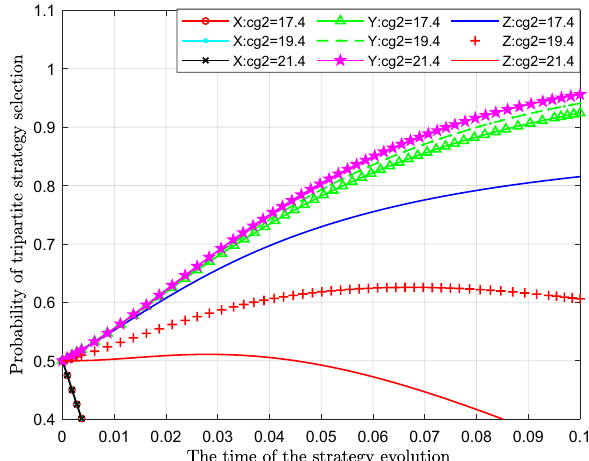
Figure 11. Effect of cost change of loose regulation by the government.